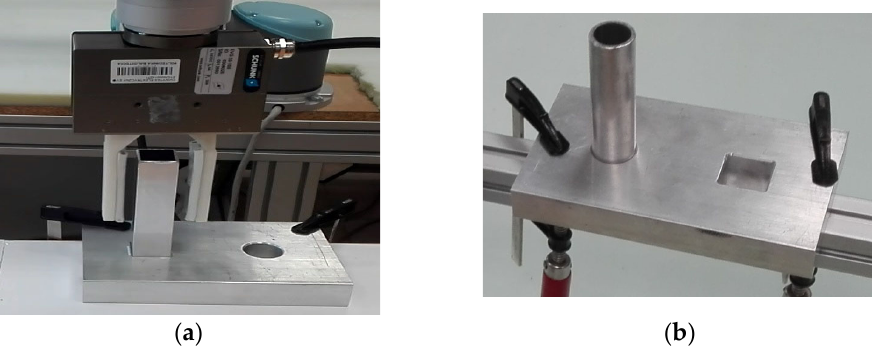
Figure 9. ( a ) Schunk EVG55 gripper with fingers designed, and ( b ) base with cylindrical and prismatic holes and cylindrical peg.